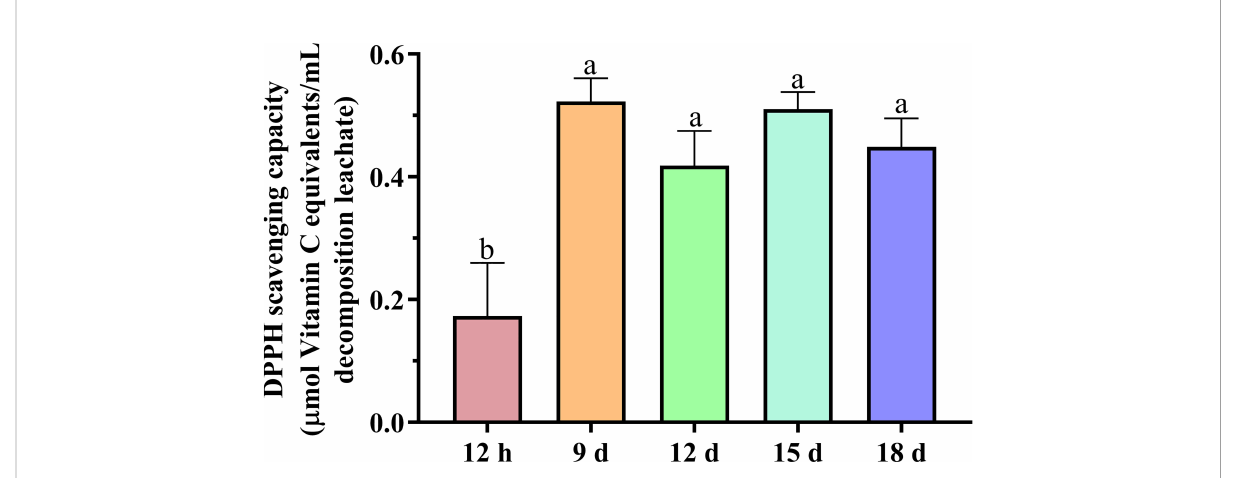
FIGURE 6 DPPH scavenging capacity of the decomposition leachates at different decay times. Different letters denoted signi fi cantly different ( P < 0.05) among different decomposition leachates of decay durations. Bars represent three repetitions ±